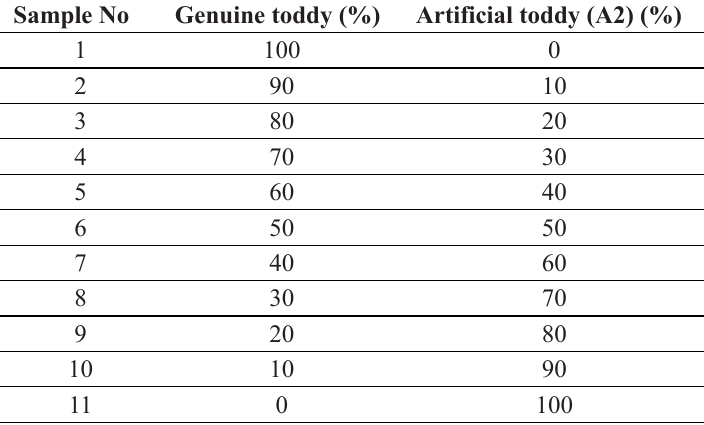
Table 1: Mixture % of genuine and artificial